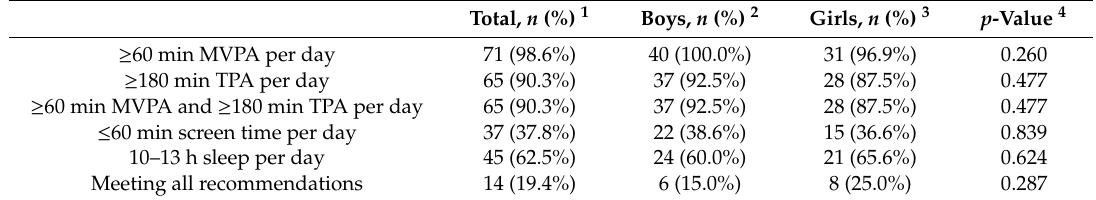
Table 2. Number and proportion of children meeting each of the 24-h movement guidelines stratified by sex 1 .